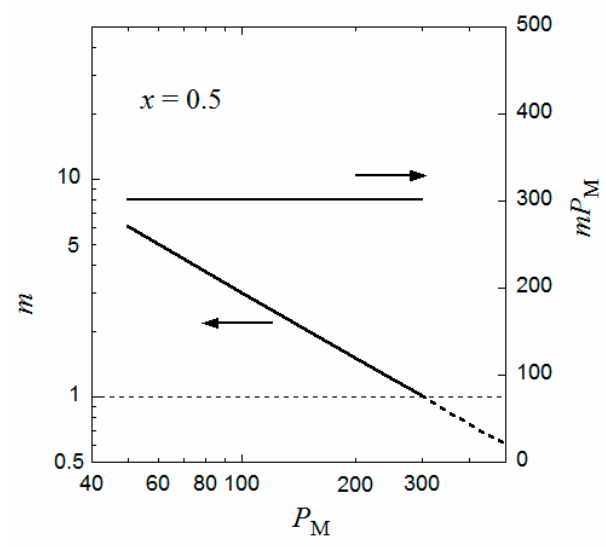
Figure 3. Degree of polymerization dependences of the aggregation number m and mP M at the interaction parameters identical to those in Figure 2.